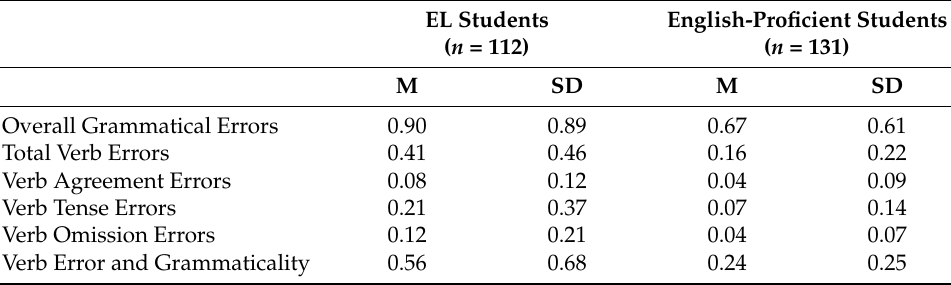
Table 3. Descriptive Statistics of Verb Use and Error Patterns by Group.